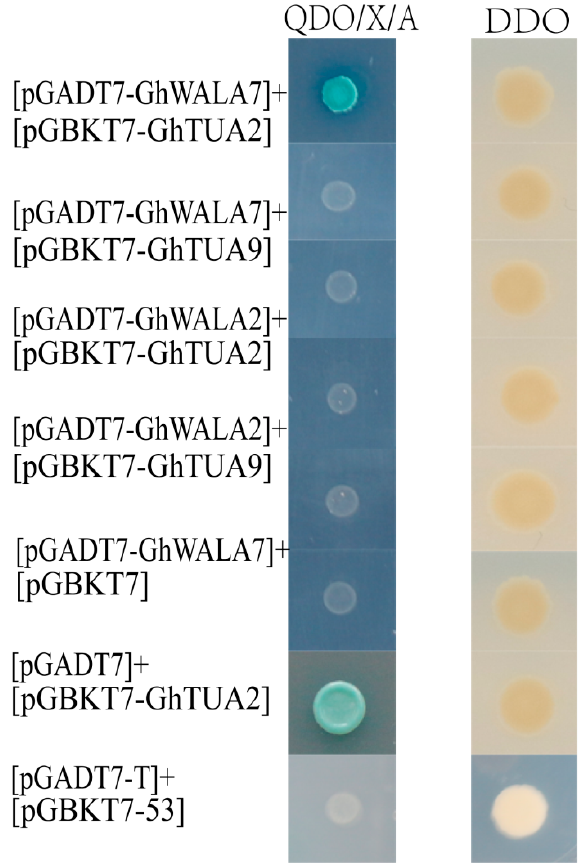
Figure 9. Yeast two-hybrid assay indicates that GhWDLA7 interacts with GhTUA2: [pGBKT7- 53]+[pGADT7-T] as positive. [pGBKT7-Lam]+[pGADT7-T] as negative.